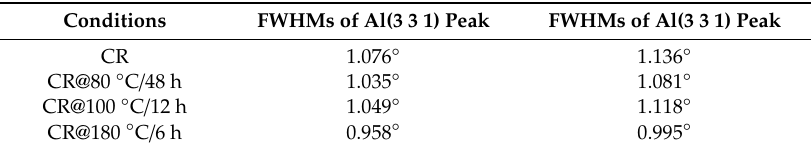
Figure 4. XRD patterns of the TiB 2 /2024 composite in different states. Table 2. The full-width at half-maximums (FWHMs) of Al(3 3 1) and Al(4 2 0) peaks for the TiB 2 /2024 composite in different states. CR: cold rolled.